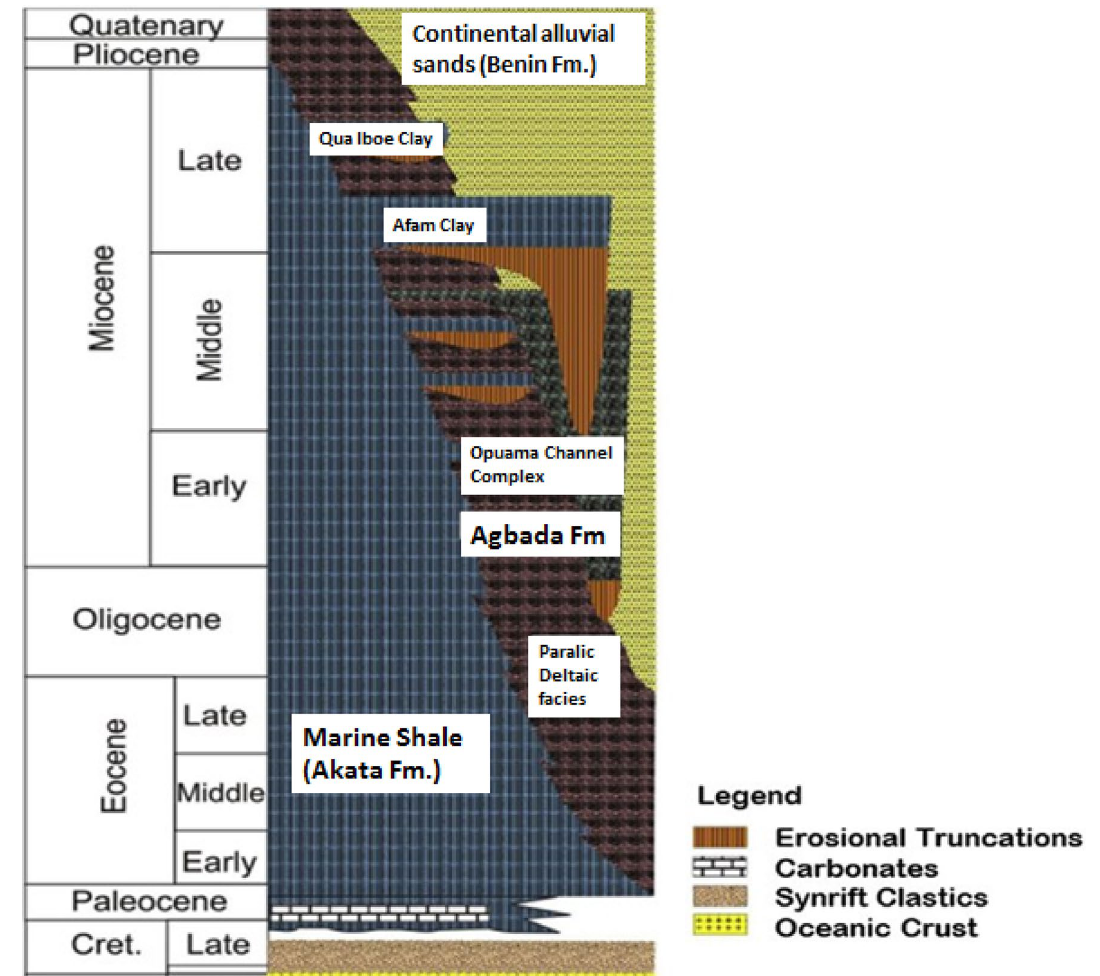
Fig. 2 Stratigraphic section of the Niger Delta, showing the three major formations (Modified after Doust and Omatsola